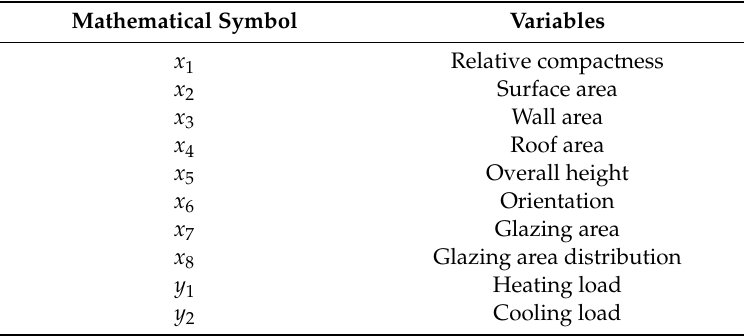
Table 1. Details of input and output